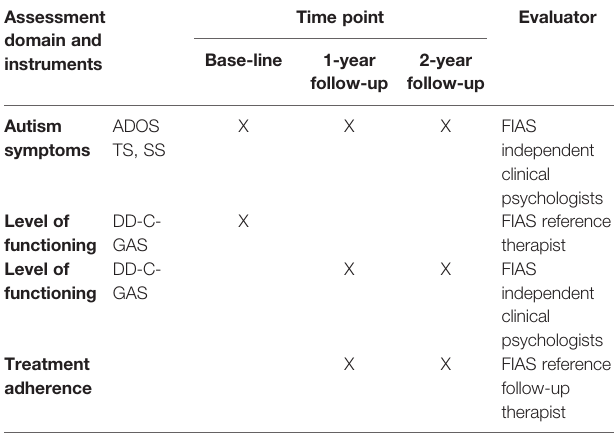
TABLE 1 | Evaluation